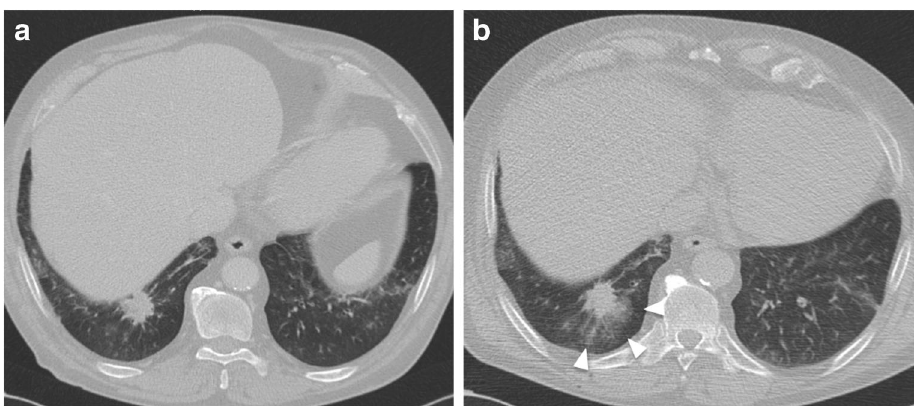
Fig. 8 CT-guided chest biopsy of a pulmonary nodule. (a) Axial CT image before the procedure showing a pulmonary nodule in the right lower lobe. (b) Post- procedural axial CT image demonstrates perilesional haemorrhage as ground-glass opacity around the